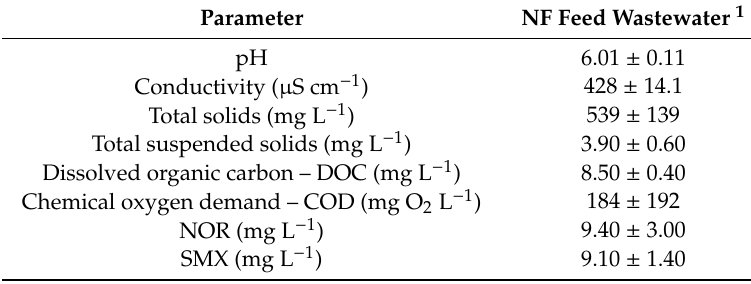
Table 3. Characteristics of the secondary treated wastewater used in nanofiltration (NF)